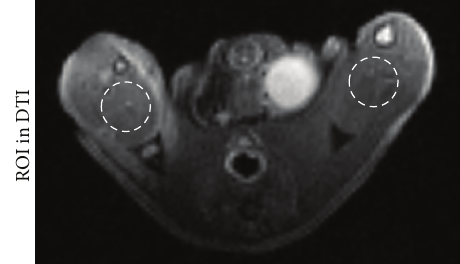
Figure 1: The example of regions of interest (ROI) for FA, ADC, 𝜆 1, 𝜆 2, and 𝜆 3 value of the gastrocnemius. ROI was drawn manually at the ischemic gastrocnemius muscle in DTI maps to measure the FA, ADC, 𝜆 1, 𝜆 2, and 𝜆 3 maps, respectively.